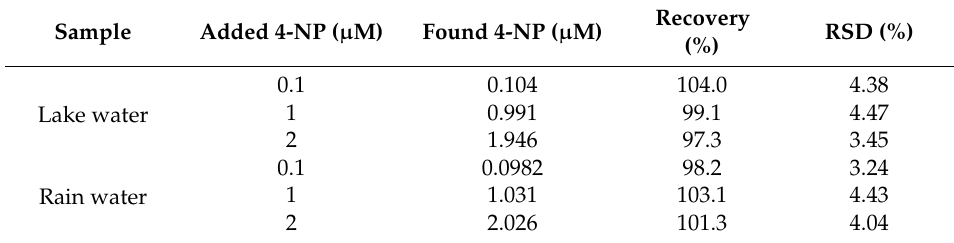
Table 3. Detection of 4-NP in water samples by poly([V 2 C 4 (mim) 2 ]Br 2 )/GCE ( n =